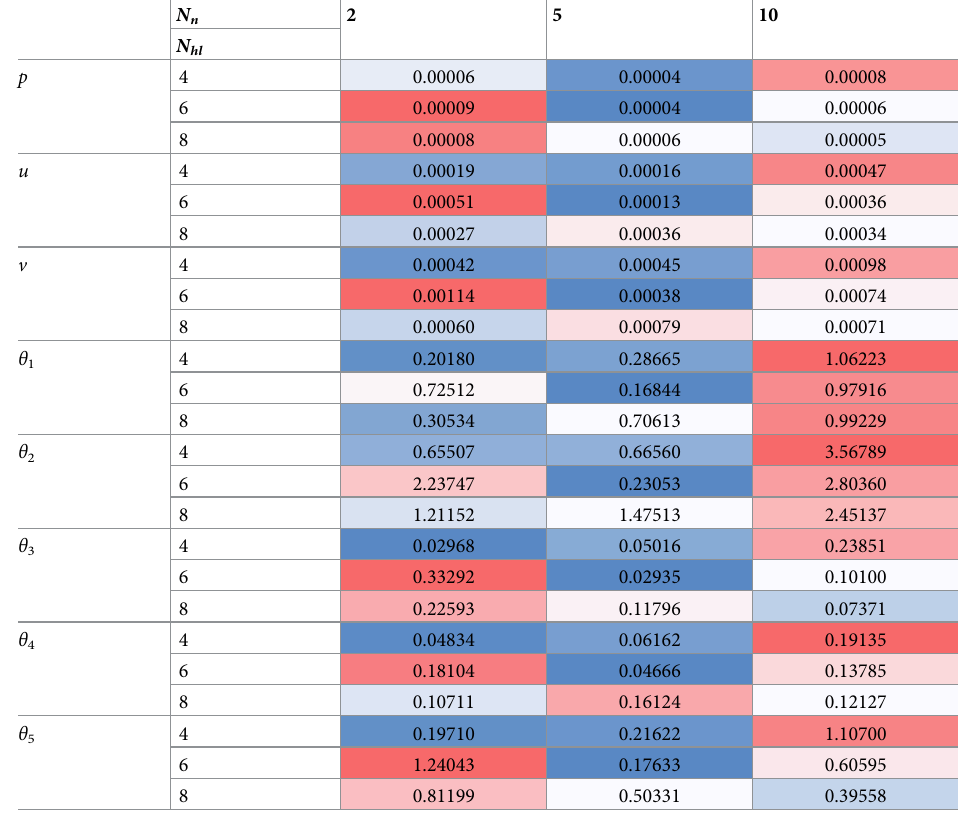
Table 7. Biot’s equations—inverse modeling: PINN performance as function of hyperparameters. Relative L 2 error of p , u , and v and percentage error of θ 1 , θ 2 , θ 3 , θ 4 , and θ 5 for different number of hidden layers, N ber of neurons per layer, N n . The N tr is fixed at 250. Note that we pick the optimal hyperparameters, i.e., N hl = 6 and N n = 20 from the sensitivity analysis of the forward model. Results shown in this table are an average over 27